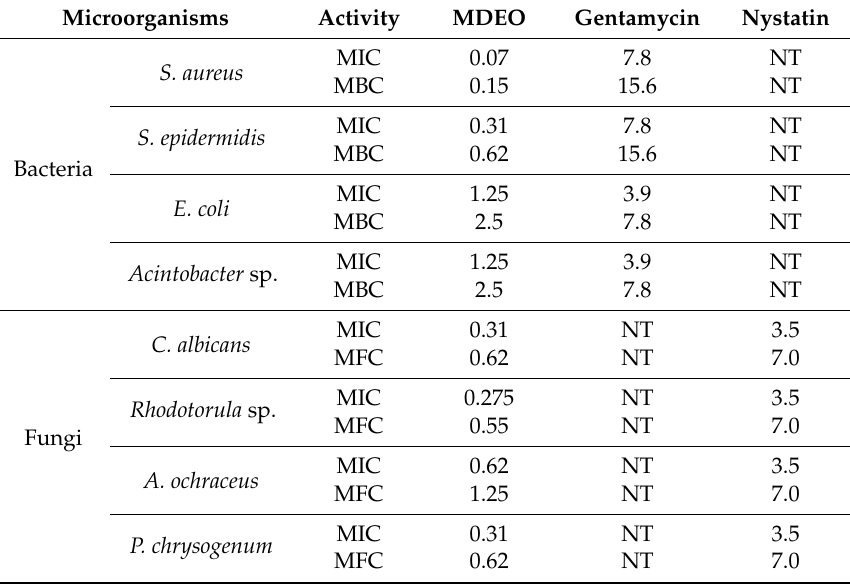
Table 3. Antimicrobial activity of the MDEO (mg / mL).